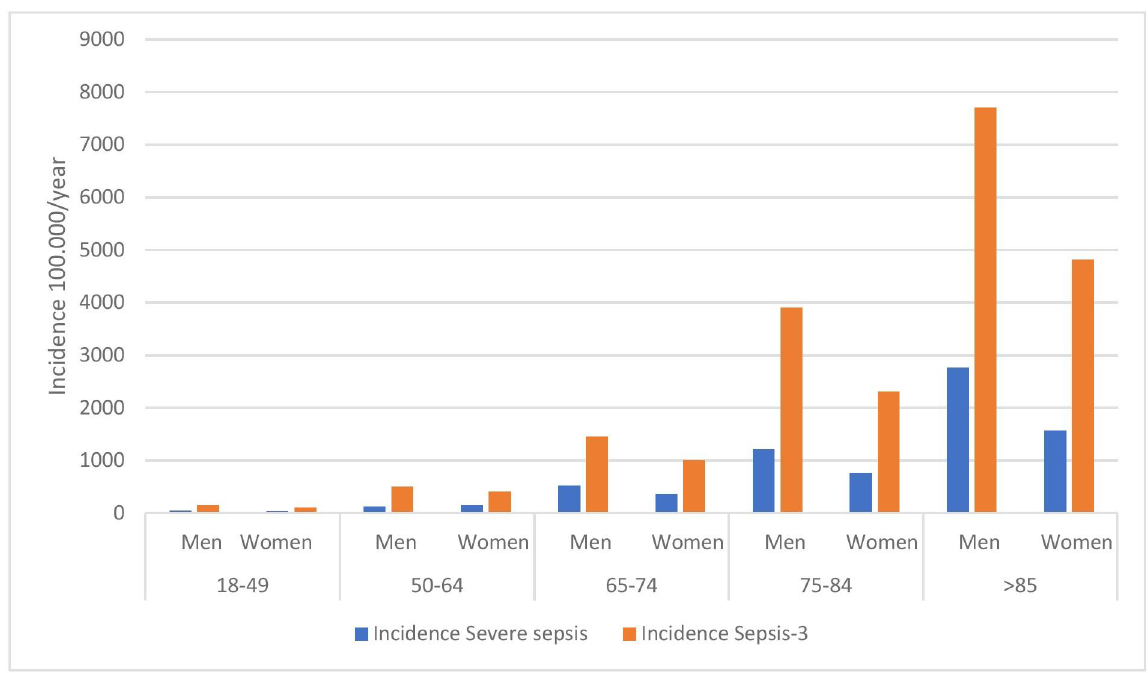
Fig 3. Incidence per 100,000 persons/year according to age group and gender of patients with severe sepsis (N = 429) and Sepsis-3 sepsis (N = 1,299).